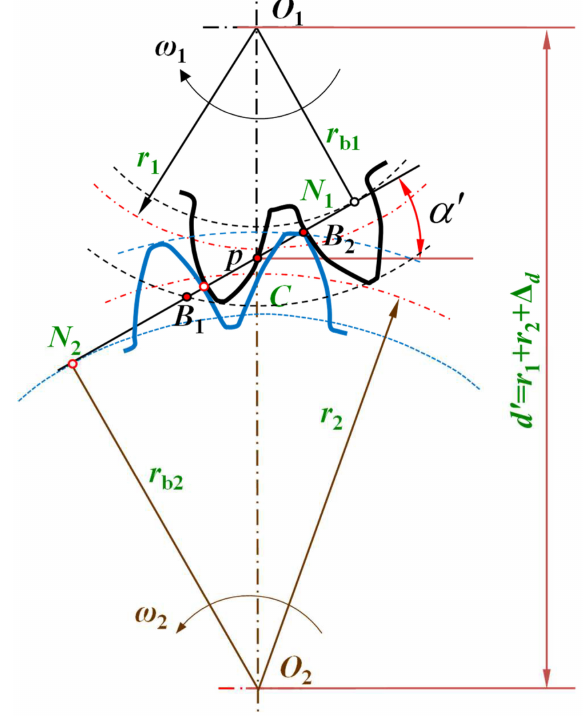
Figure 1. Schematic diagram of the mesh theory of involute gear pair.